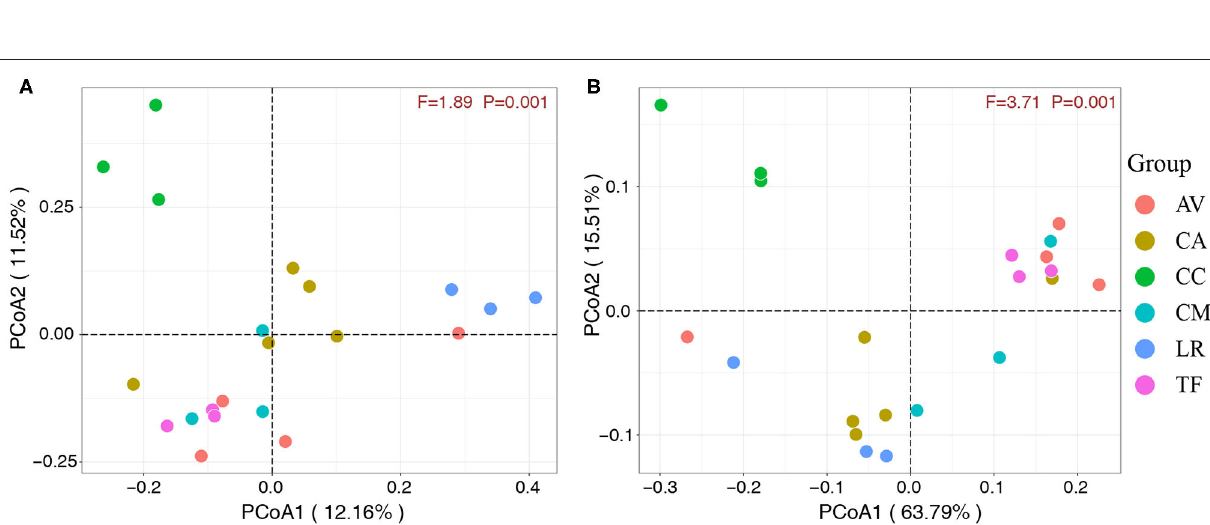
Frontiers in Veterinary Science | www.frontiersin.org